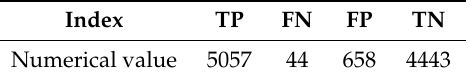
Table 18. Forecast indices value.